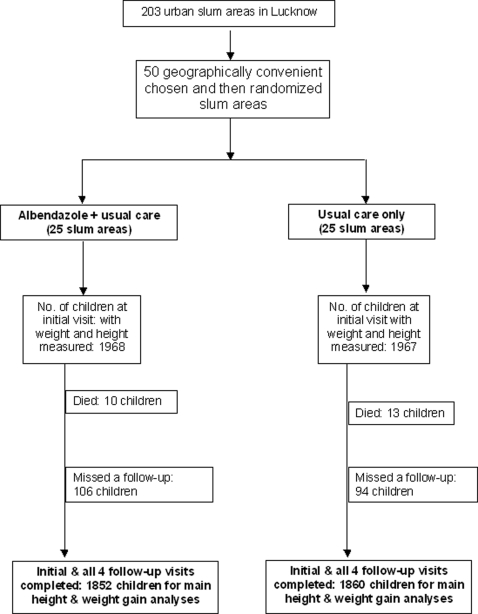
CONSORT Flow Chart